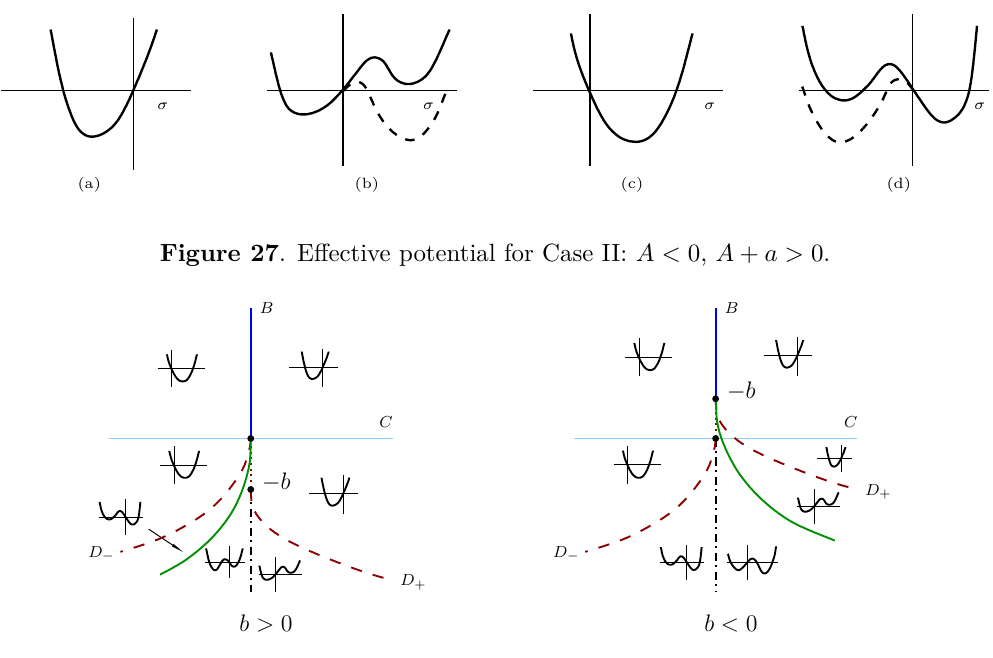
Figure 28 . Detailed structure of the potential for Case II: A < 0 , A + a > 0 . Refer to the caption of figure 24 for details on the various marked